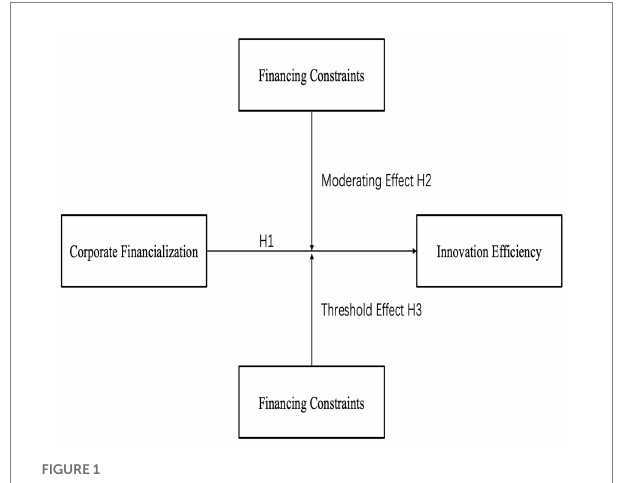
FIGURE 1 Research framework